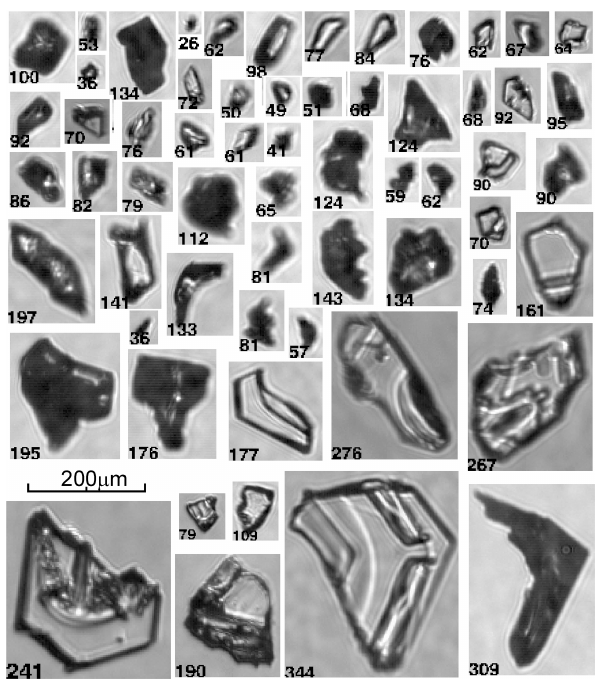
Figure A4. Examples of CPI images identified as shattering arti- facts. Such images were excluded from